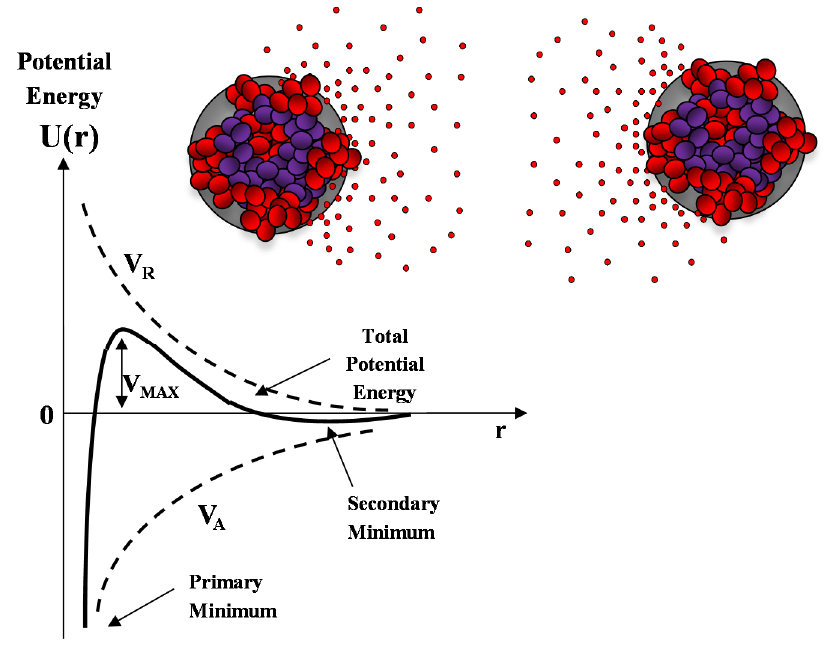
Figure 10. Sketch of the DLVO interaction potential energy as a function of particle separation r. The net potential energy is given by the sum of the double layer repulsion V R and the van der Waals attractive forces V A .